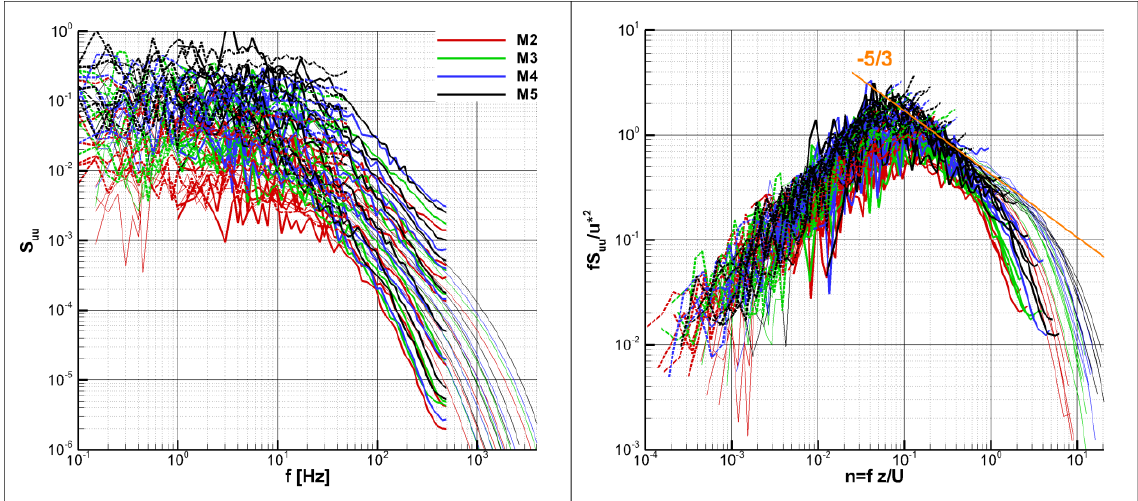
Fig. 4. Spectral curves for all setups, all free stream velocities, and both measurement method (HW thin solid line, PIVD bold solid line, PIVS dashed line) at the height z=0.33δ in dimensional representation (left) and dimensionless form (right).